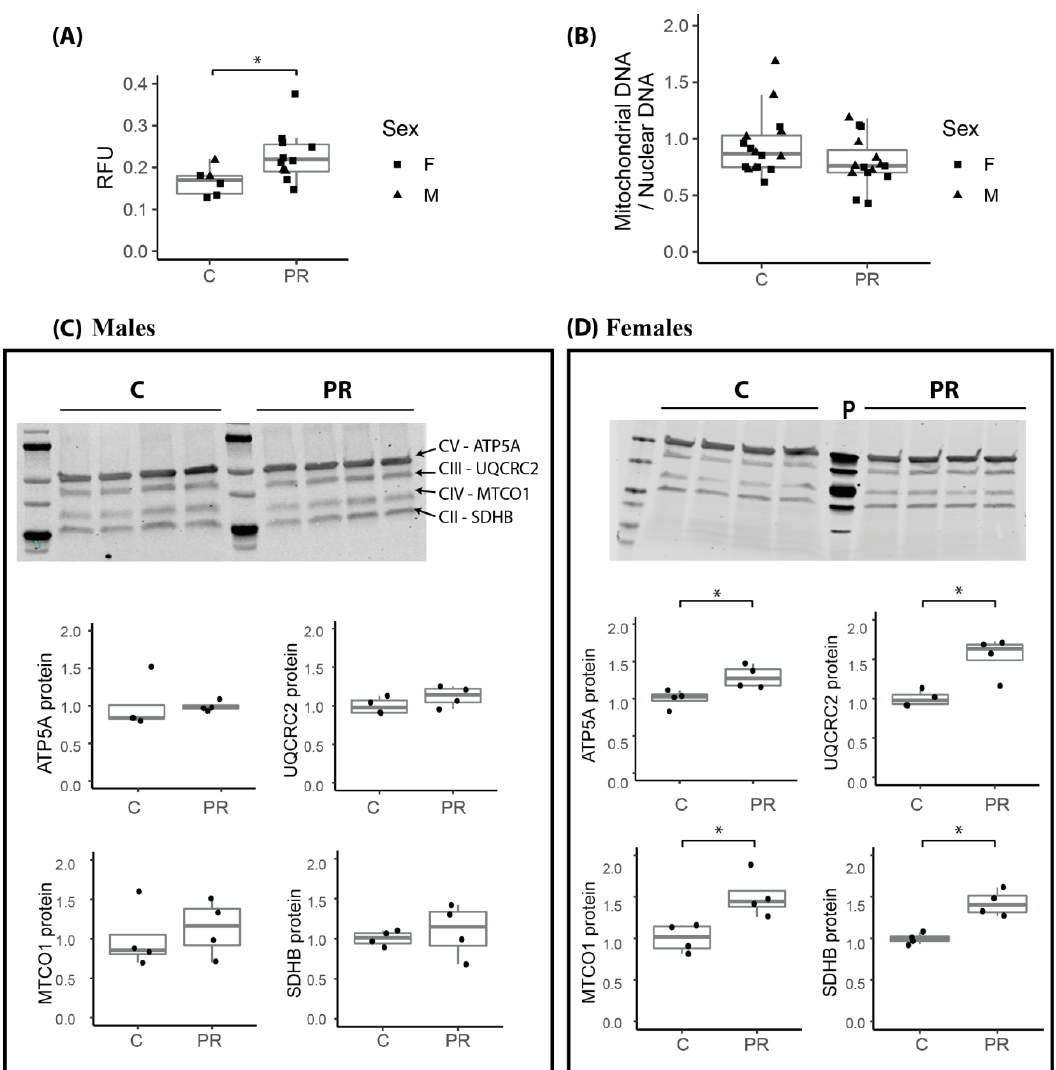
Figure 5. Mitochondrial membrane potential, DNA and protein quantification from total E17 fetal hypothalamus. ( A ) Mitochondrial membrane potential was quantified in dissociated total fetal hypothalamus cells by MitoTracker Red CMXRos and expressed in Relative Fluorescence Units (RFU)/lived cells x 1000 (C: n = two males + four females, PR: n = two males + nine females) (two-way ANOVA: group effect * p = 0.04, sex effect p = 0.91). ( B ) Mitochondrial DNA was quantified using qPCR amplification on total DNA from E17 whole hypothalamus of the mitochondrial CytB gene and normalized with two nuclear genes Gapdh and Zfx-Zfy . ( C , D ) Four proteins from the mitochondrial respiratory chain complexes (SDHB, MTCO1, UQCRC2 and ATP5A from Complexes II, III, IV and V, respectively) were quantified using Western blot on total proteins from E17 total hypothalamus in four males ( C ) and four females ( D ) from each group. Total protein stain was used for normalization. (Mann Whitney * p < 0.05) (p: Positive control = mitochondrial protein extract from rat heart tissue lysate (Abcam ab110341)) (boxplot: median, first and third